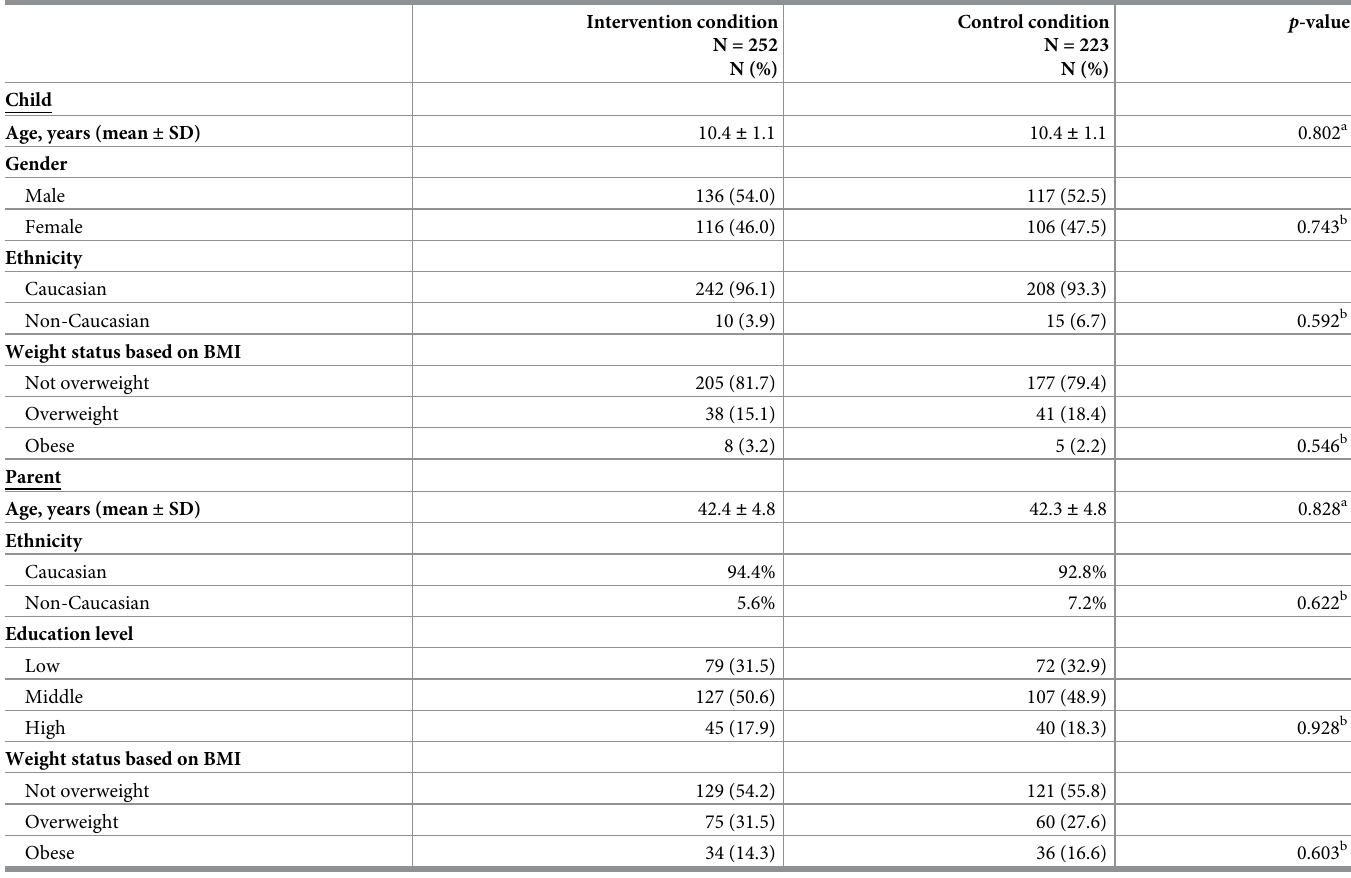
Table 1. Demographics and weight-related characteristics of the entire study